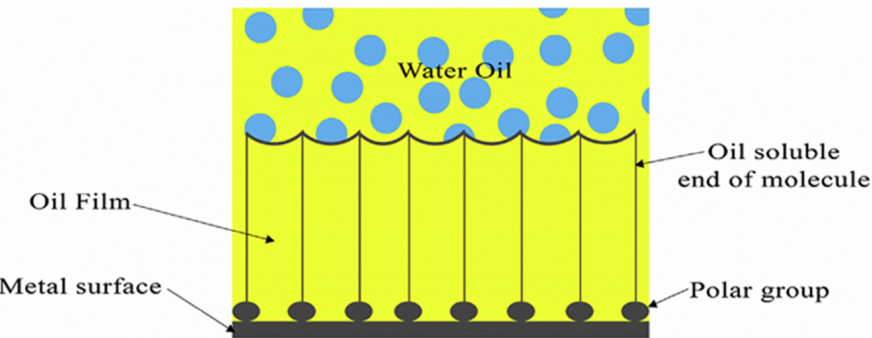
Figure 4. Schematic figure of the film formed by corrosion inhibitor. Reprinted with permission from Ref. [45]. 2018,